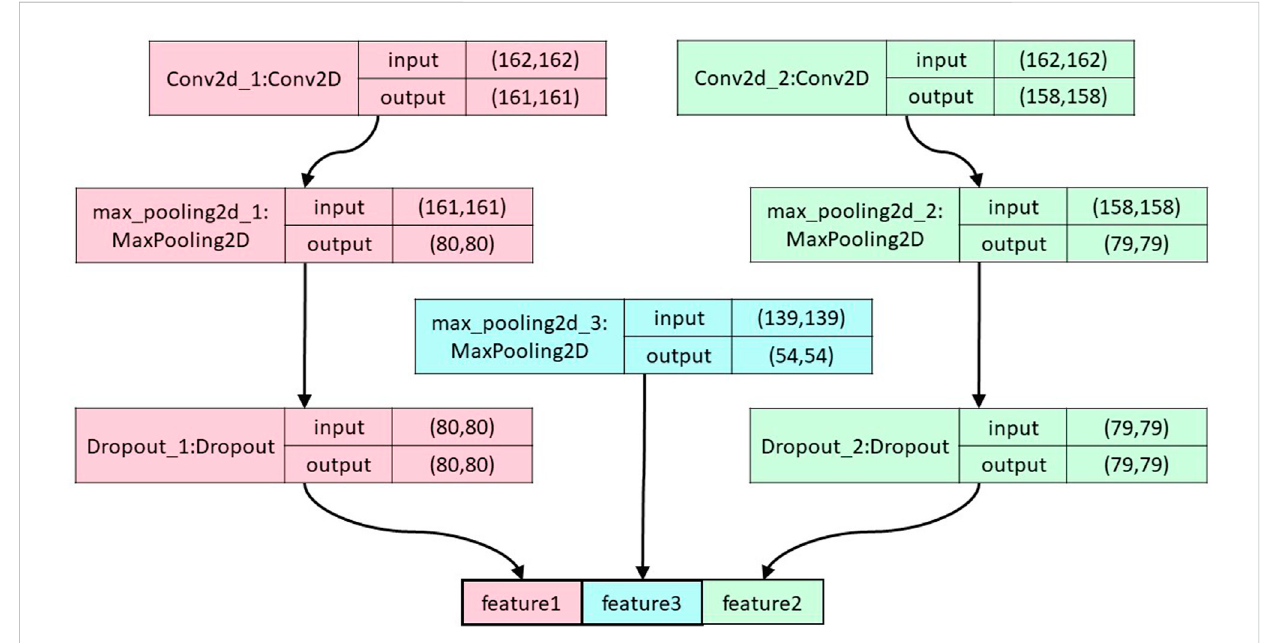
FIGURE 2 The overall structure of the convolutional pooling layer. The fi gure shows the segerstolpe dataset as an example.